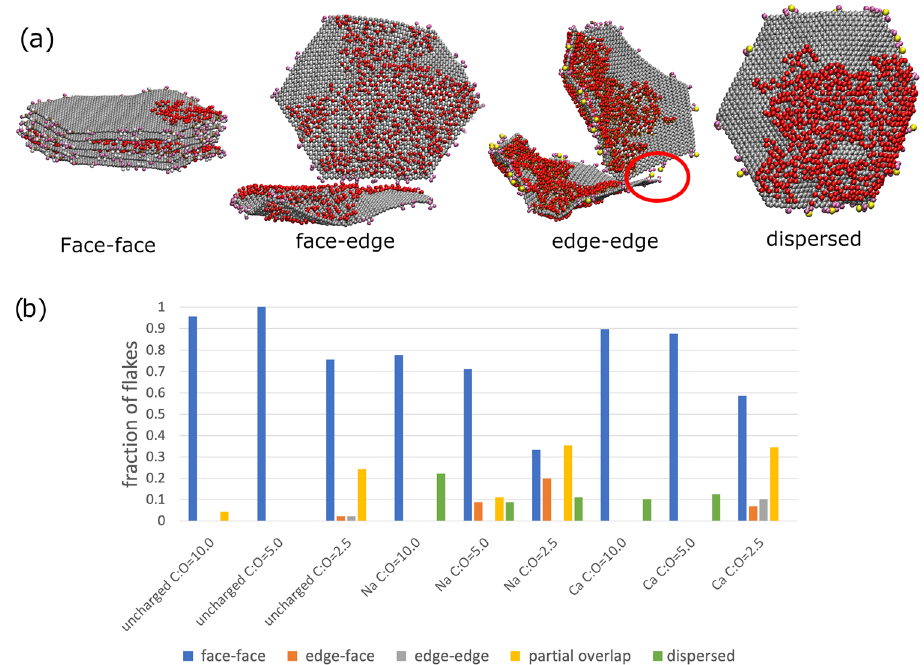
Figure 3. Aggregation interaction modes present in graphene oxide flakes in aqueous solution. ( a ) Snapshots from the coarse-grained simulations illustrating the relevant binding mode. The red circle on the edge-edge mode. The colour scheme is the same as Figure 1. In ( b ), we display the percentage of flakes in each binding mode for the different systems in our study. The different binding modes (“face-face”, “partial”, “edge-edge”